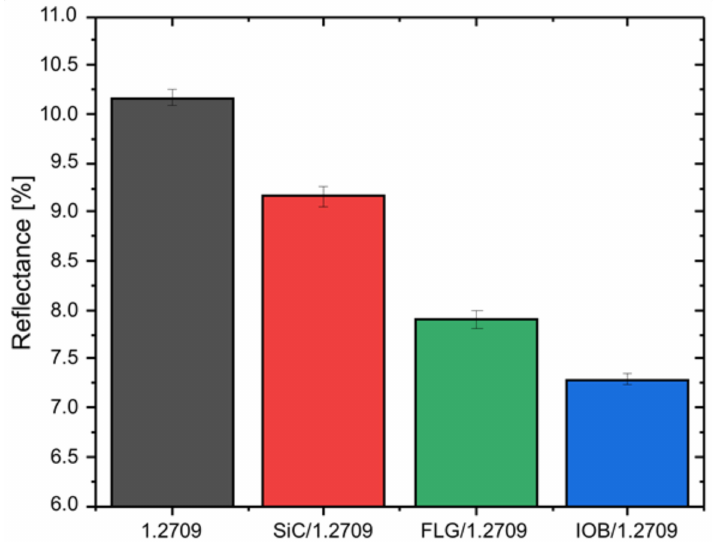
Figure 6. Reflectance measurements of the coated and uncoated tool steel 1.2709 powder at a wavenumber of 9398 cm − 1